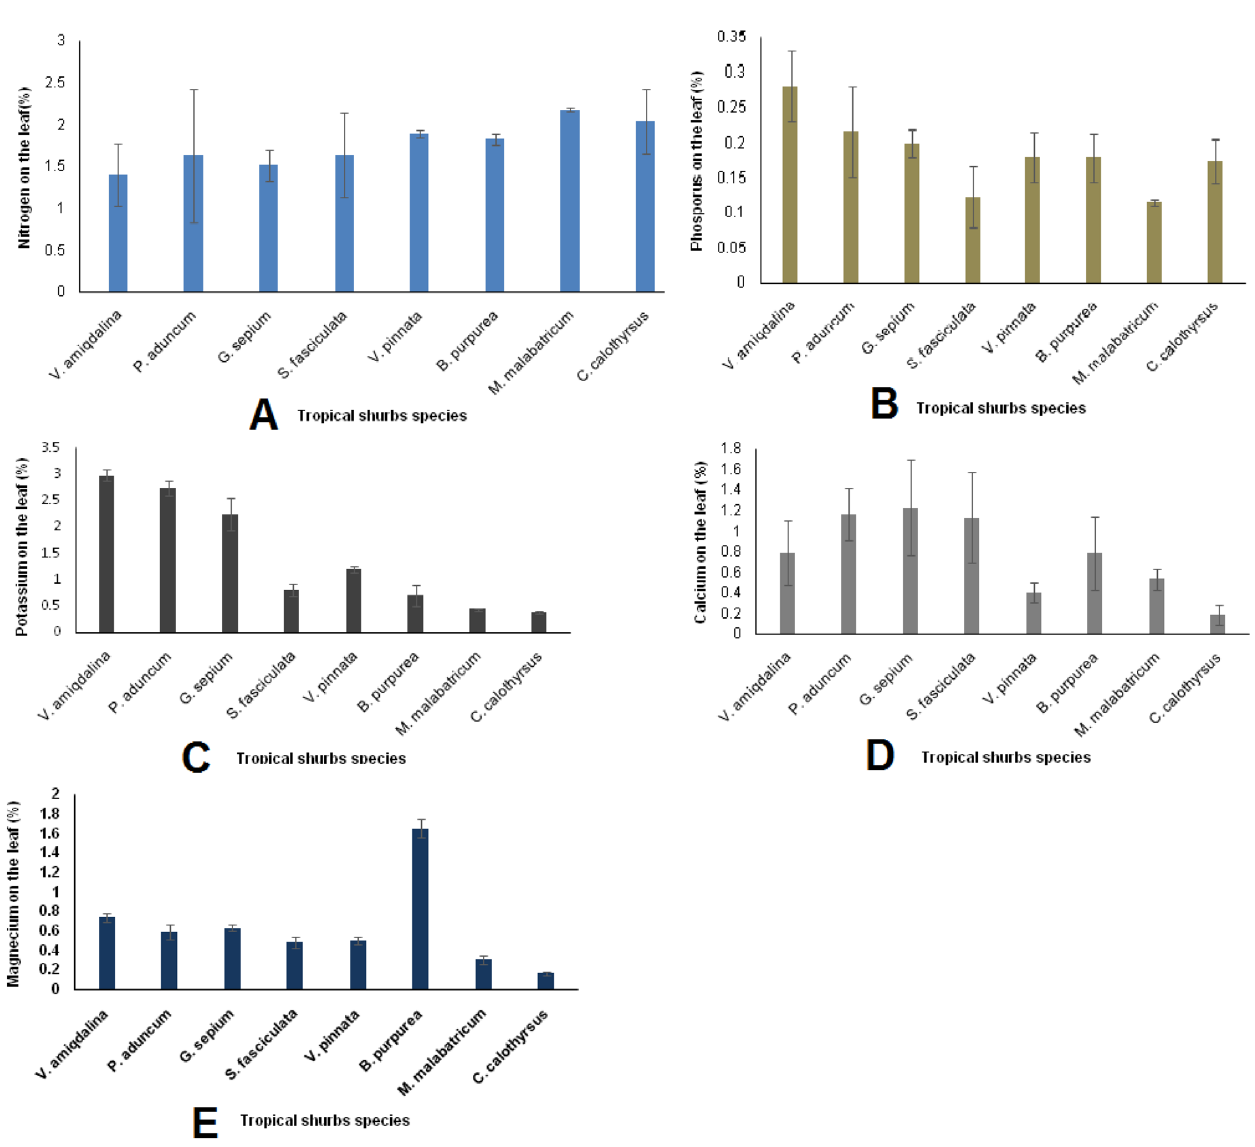
Figure 3. Nutrient accumulation in leaves of tropical shrubs 5 months after planting measured from all fertilizer applications ( A . Nitrogen, B . Phosphorus, C . Potassium, D . Calcium, and E . Magnesium).